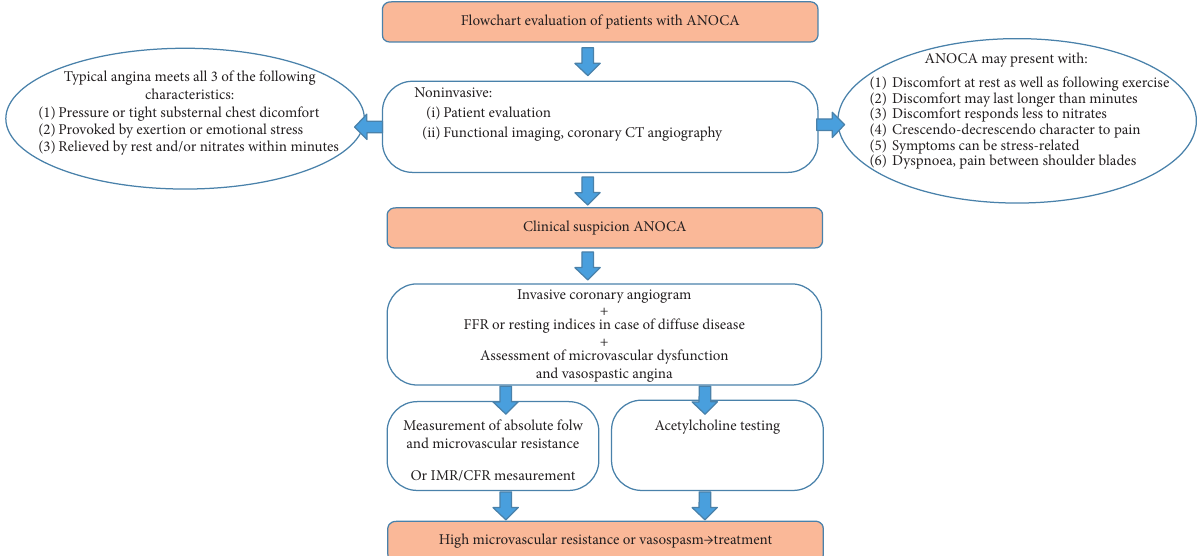
Figure 1: The evaluation of ANOCA patients in a flowchart. ANOCA: Angina with Nonobstructive Coronary Arteries, CT: computed tomography, FFR: fractional flow reserve, IMR: index of microvascular resistance, and CFR: coronary flow reserve.